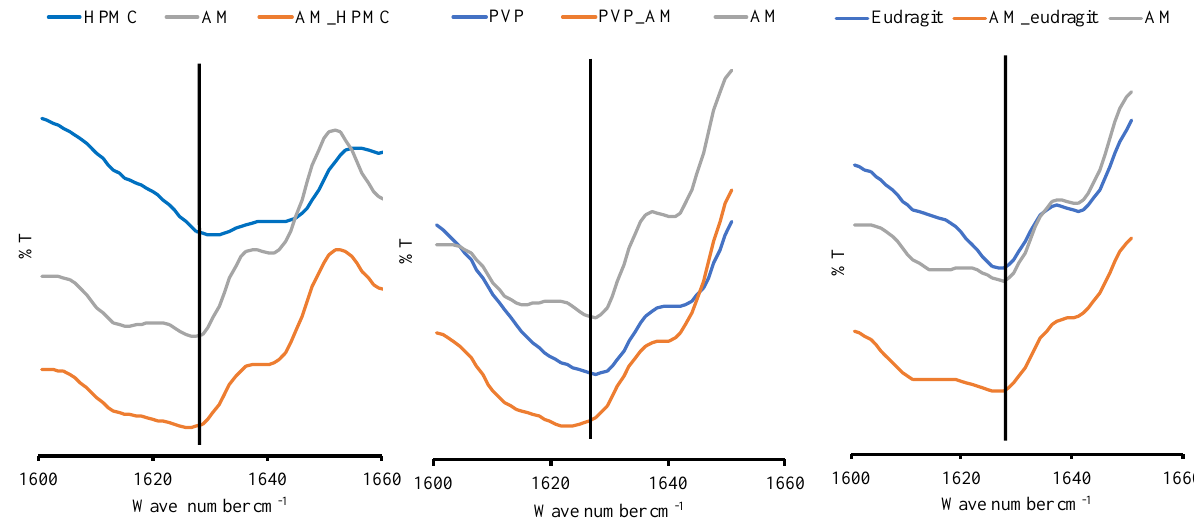
Figure 7. FT − IR spectrum of each sample in the range of 1600 − 1660 cm − 1 .